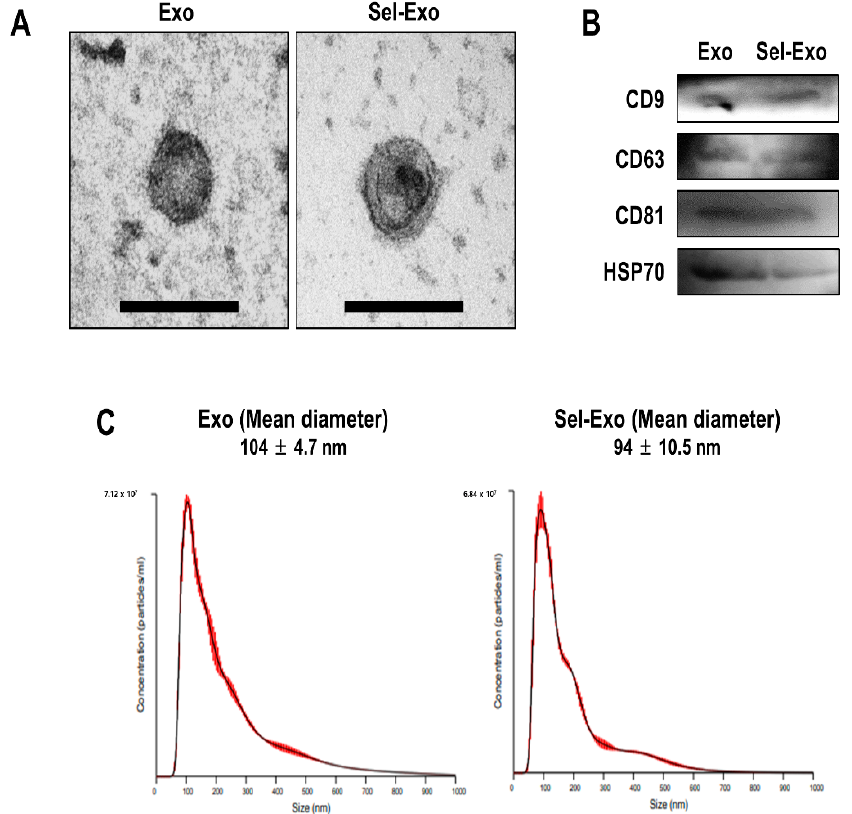
Figure 2. Characterization of exosomes (Exo) and selenium-treated exosomes (Sel-Exo) derived from AdMSCs. ( A ) Morphology of Exo and Sel-Exo was analyzed by transmission electron microscopy (TEM) (scale bar = 200 nm). ( B ) The exosomal markers (CD9, CD63, CD81, and HSP70) for Exo and Sel-Exo were evaluated by Western blotting. ( C ) The mean size of the particles for Exo and Sel-Exo was measured by nanoparticle tracking analysis (NTA).